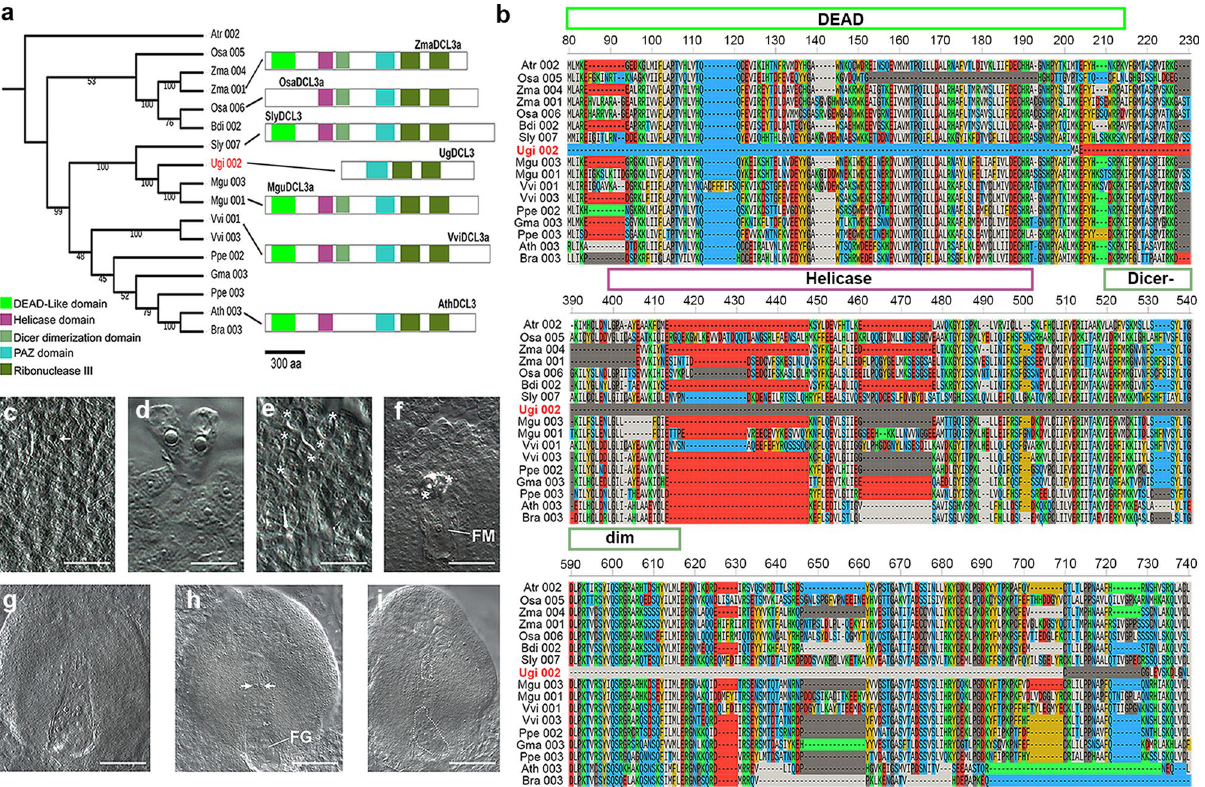
Figure 4. Truncated DCL3 and female gametophyte development in the ovule of U. gibba. ( a ) Phylogenetic analysis of DCL3 in some angiosperms including U. gibba . A typical DCL3 protein has the DEAD, Helicase, Dicer dimerization, PAZ, and two Ribonuclease III domains, while UgDCL3 only contains the PAZ and Ribonuclease III domains. ( b ) Multiple sequence alignment of DCL3 proteins in blocks of 150 aa showing the missing domains in UgDCL3. ( c ) Developing ovules showing a single pre-meiotic precursor corresponding to the MMC. ( d ) Twin pre-meiotic precursors prior to megasporogenesis. ( e ) Six differentiated cells (asterisk) corresponding to gametic precursors prior to megasporogenesis. ( f ) Functional megaspore (FM) and two degenerated megaspores (asterisk) following megasporogenesis. ( g ) Developing ovule showing a single 8-nuclear female gametophyte. ( h ) Developing ovule showing a female gametophyte (FG) and two ectopic gametic precursors (arrows) at the chalazal region. i Developing ovule showing two independent female gametophytes (dashed). Scale bars: 12.5 µm in ( c ) to ( f ); and 20 µm in ( g ) and ( i